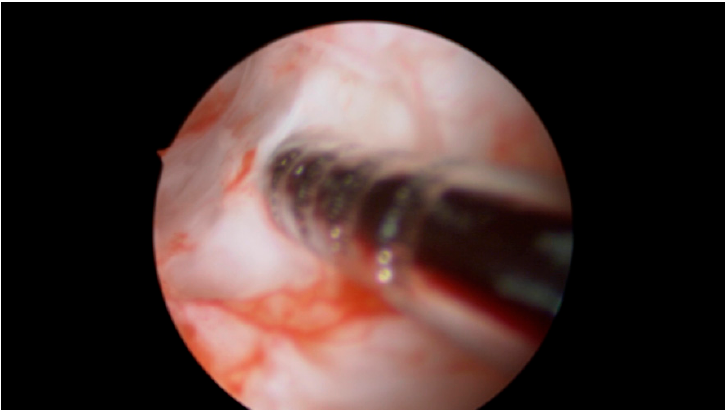
Figure 2. Hysteroscopic instillation of PRP, the beveled edge of the ovum. pick up needle is oriented towards the uterine cavity in order to determine the exact depth of insertion.